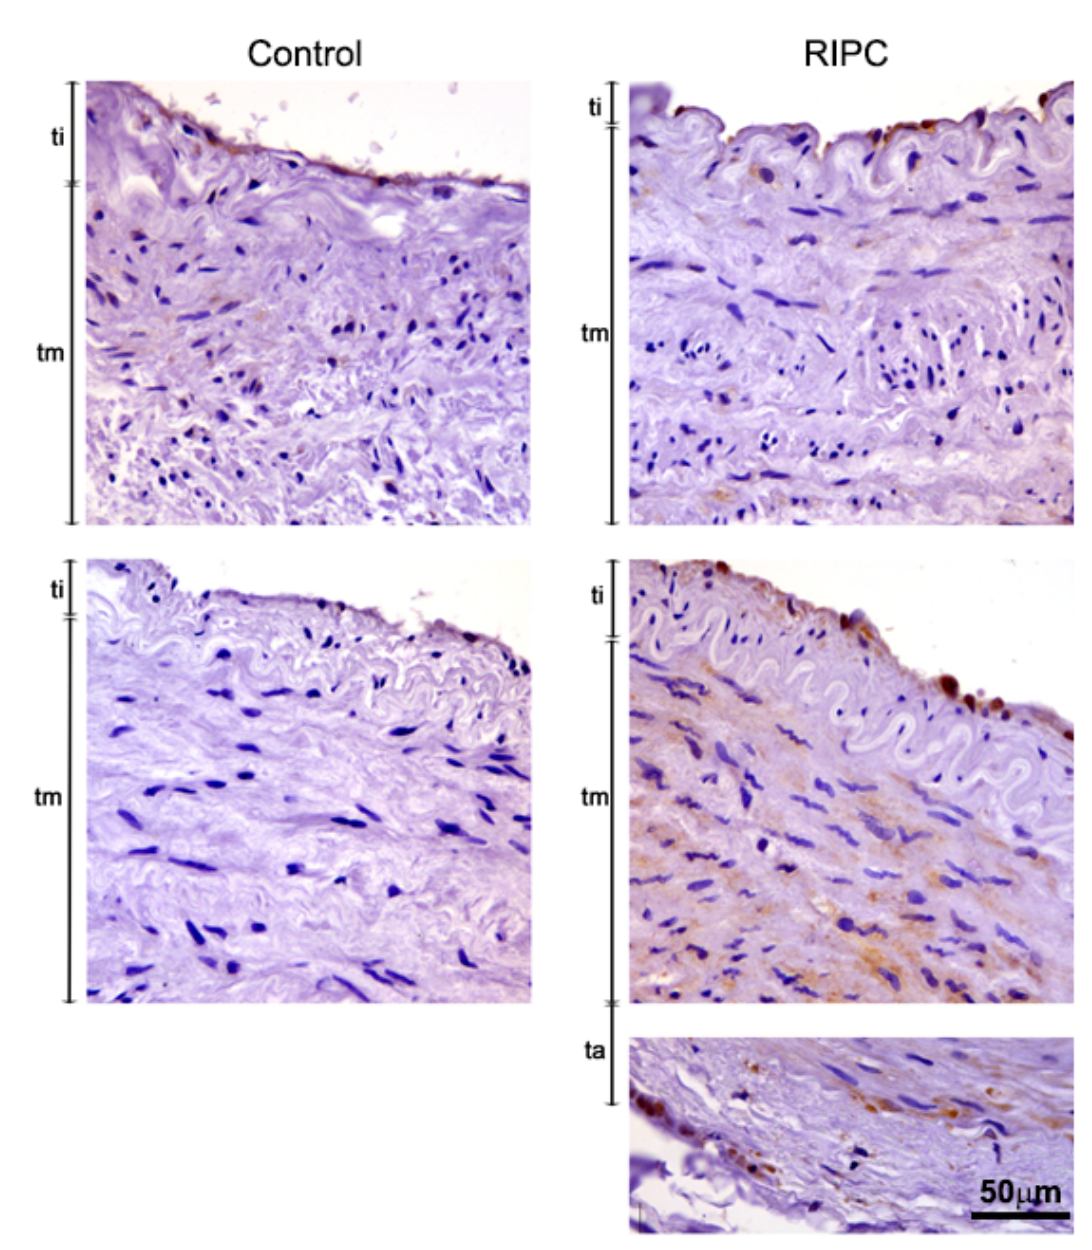
Figure 2. Immunohistochemical analysis of eNOS in tunica interna (ti), tunica media (tm) and tunica adventitia (ta) of ITA from non-RIPC (control) patients ( left ) and patients with applied RIPC protocol ( right ) during urgent CABG. Immunopositivity for eNOS in non-RIPC patients is mostly visible in the endothelium, while RIPC patients demonstrate high eNOS immunopositivity in all three layers of ITA. Scale bar: 50 μ m.